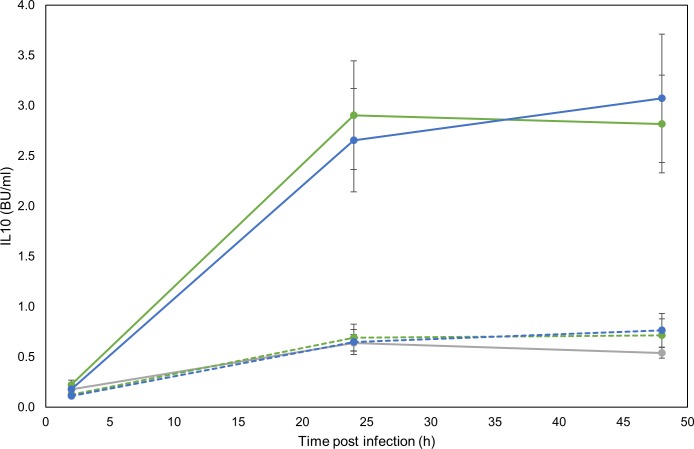
Successful knock-down of IL10 with siRNA.Graph illustrating successful knock-down by siRNA of IL10 protein production during infection with M. bovis strains AF2122/97 (green lines) and G18 (blue lines). Solid lines denote bMDM treated with NTC siRNA and dotted lines denote bMDM treated with IL10 siRNA 48 h prior to infection. The grey line represents IL10 production by uninfected bMDM. Error bars denote the standard error of seven biological replicates.